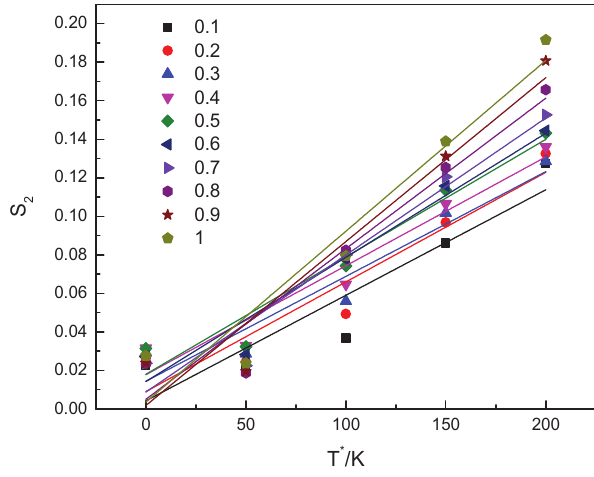
Figure 14: Relationship between S 2 and T * at different strains.